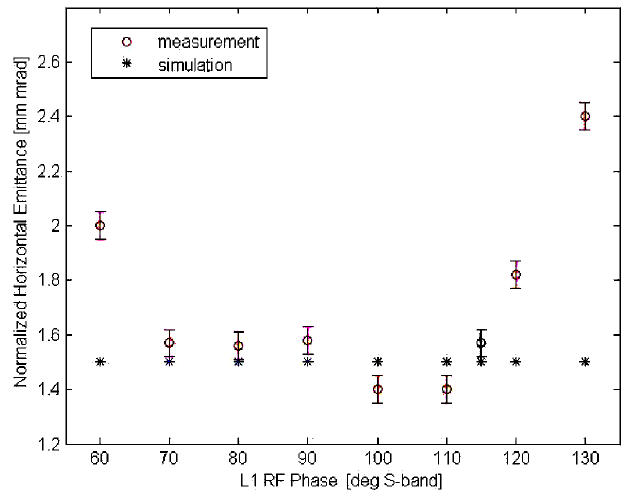
FIG. 5. Comparison of the normalized horizontal emittance measured and simulated as a function of the L1 rf phase. BC1 is set straight. The maximum beam energy is for 90 (cid:3) . A relative emittance growth smaller than 1% is predicted by particle tracking over the range of rf phases considered